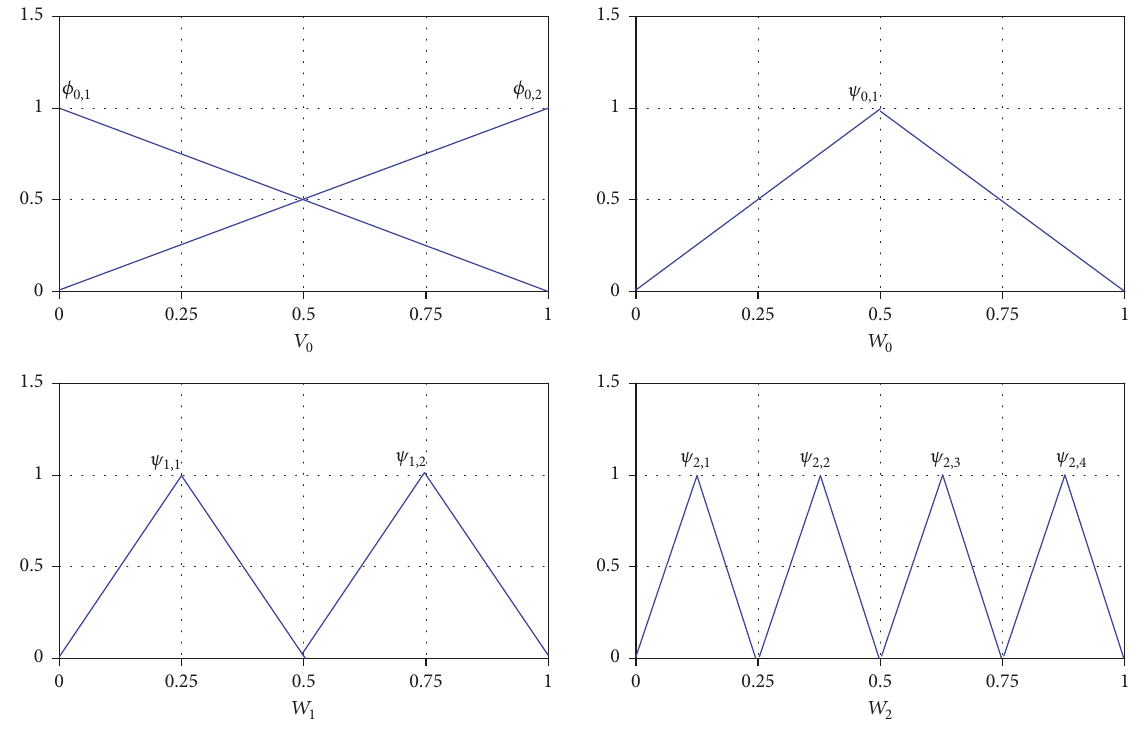
Figure 1: Lagrange wavelet shape